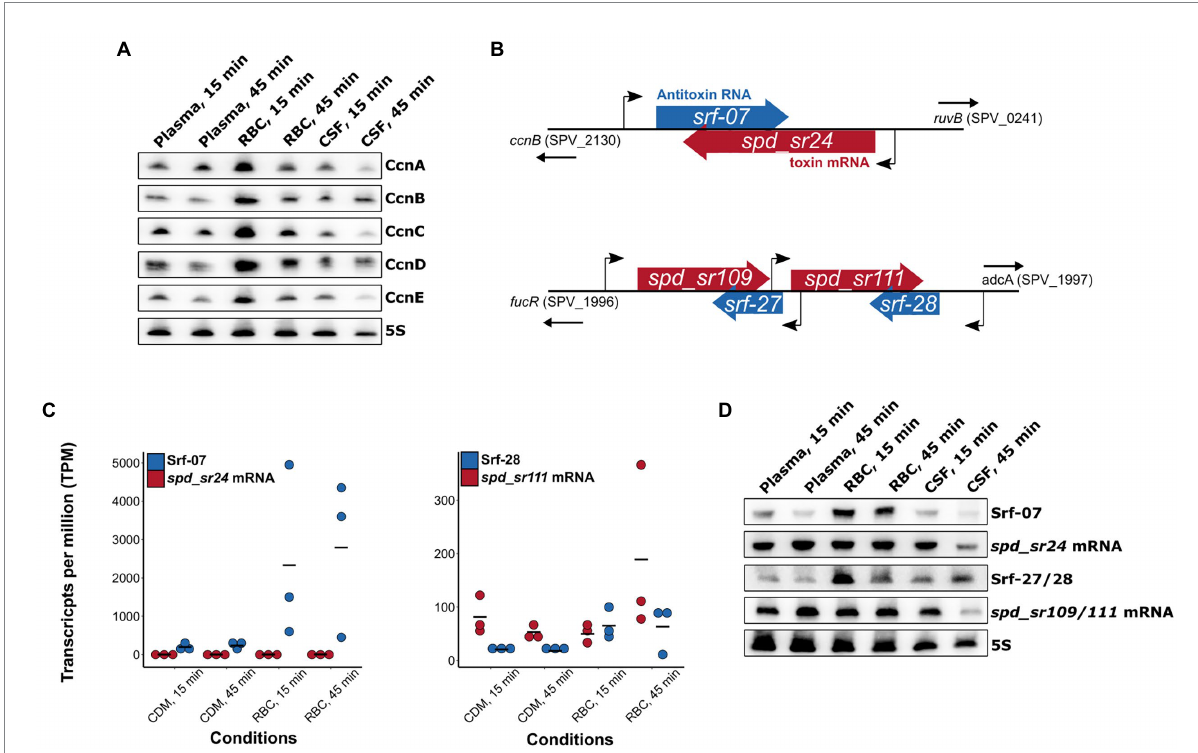
FIGURE 7 Validation of differentially expressed sRNAs. (A) Despite only CcnB and CcnD being identified as significantly differentially expressed in RBC cultures, all CiaR-dependent small RNAs (CcnA-E) showed a similar expression pattern, as expected. (B) Genetic context of differentially expressed RNAs belonging to the two pneumococcal Fst-like type I toxin-antitoxin (TA) loci. (C) Transcripts per million (TPM) calculations based on the RNA- seq data show a general molar excess of antitoxin RNA in the Srf-07/spd_sr24 TA system, but not in the Srf-28/spd_sr111 nor Srf-27/spd_sr109 TA systems. (D) Validation by northern blot (NB) analysis of toxin-and antitoxin RNA expression patterns from RNA-seq experiments. Expression pattern observed by NB analysis of antitoxin mRNAs were not consistent with RNA-seq